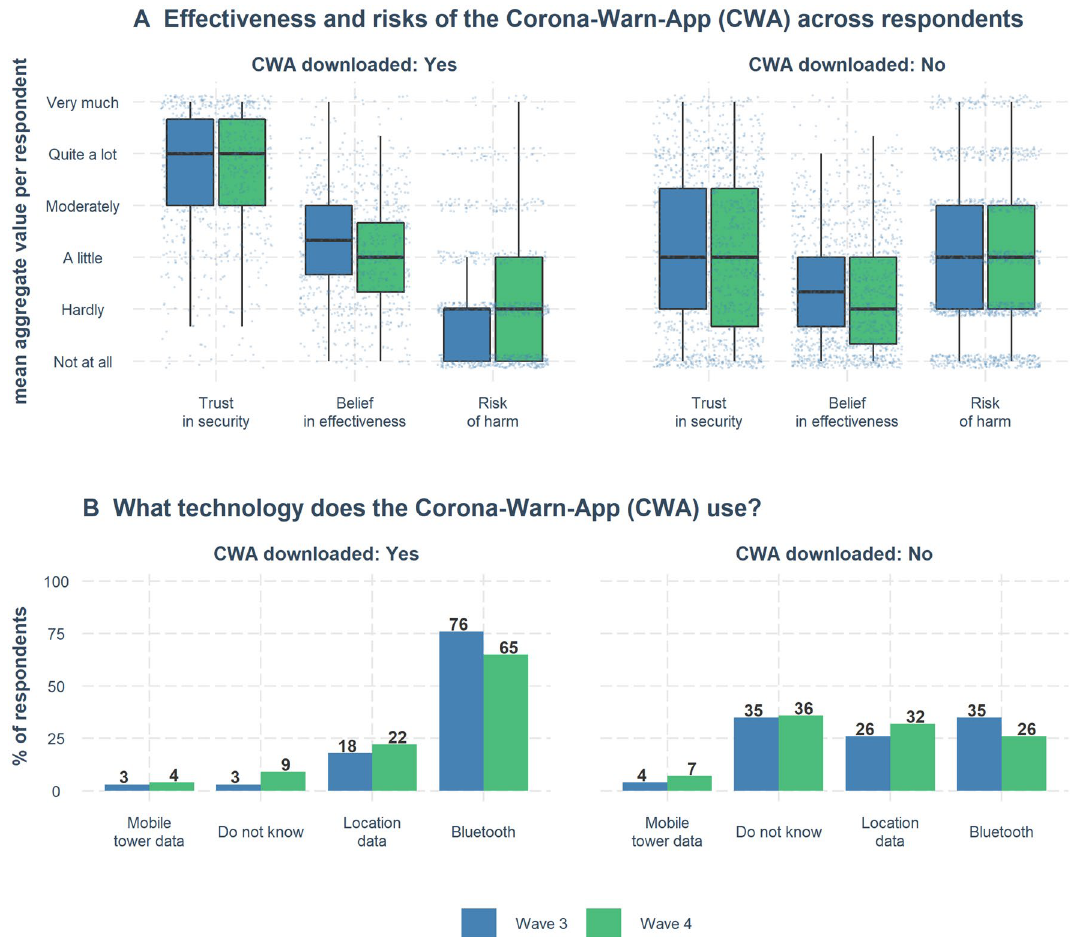
Figure 7. Users and non-users of the Corona-Warn-App: Perception of effectiveness, risks, and understanding of technology. ( A ) Perception of effectiveness and risks of the Corona-Warn-App for two groups: those who had downloaded the app and those who had not. The variables “Trust in security” and “Belief in effectiveness” represent combined and averaged measures from variables presented in Fig. 6. The variable “Trust in security” combines four variables: “Only Necessary Data Collection,” “Trust: Privacy Protection,” “Trust: Security from 3rd Party.” The variable “Belief in effectiveness” combines three variables: “Reduce Likelihood to Contract,” “Reduce Spread Future,” “Return to Activity Future.” “Risk of harm” is a single variable. For items, see Appendix Tables B6 and for all aggregate measures see B10. Boxplots show distributions of aggregate (mean) values. Boxes show the interquartile range (IQR; responses between the 25th and 75th percentiles); the black horizontal line inside the boxes indicates the median value. Lower and upper whiskers extend from the hinge to the smallest and largest values within 1.5 × IQR . Individual responses are jittered horizontally and vertically. ( B